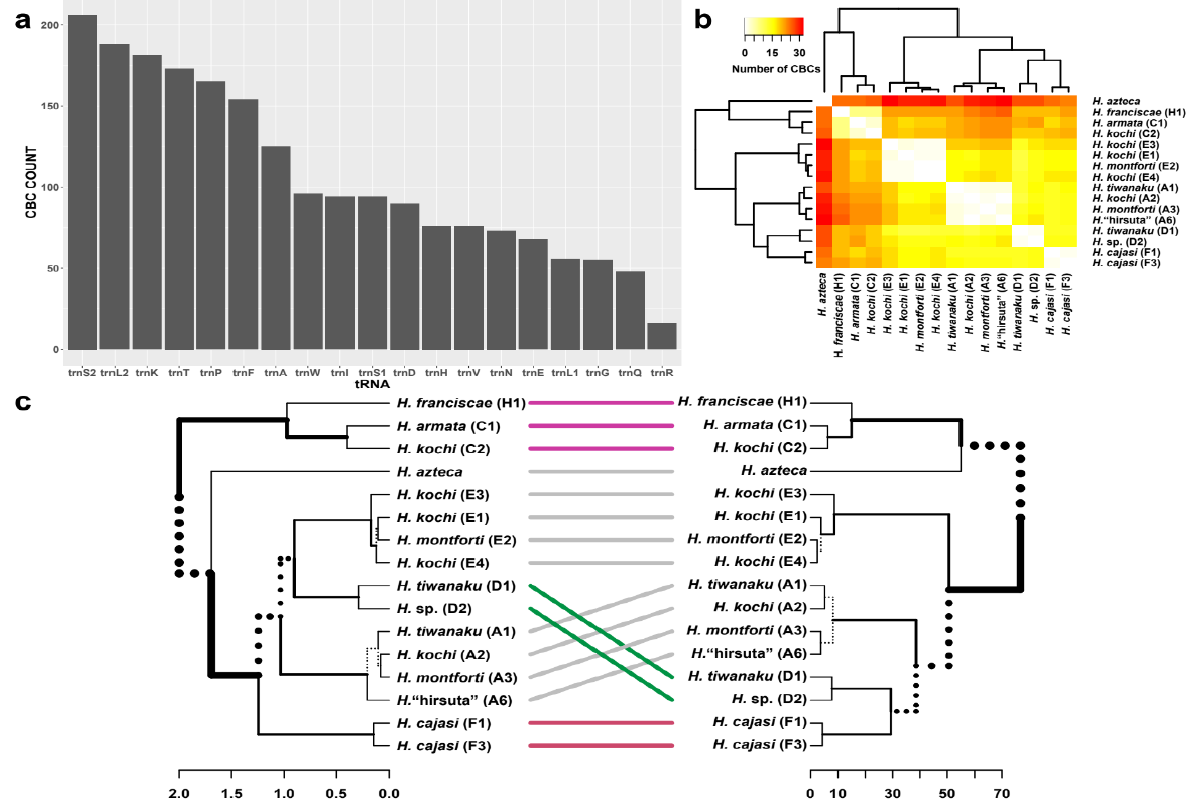
Figure 5. Analysis of the compensatory mutations. Bar plot showing the number of compensatory base changes (y-axis) in Hyalella tRNAs (x-axis) ( a ). Heatmap summarizing results of the hierarchical clustering analysis. Warmer colors (red–orange) indicate a higher number of compensatory base changes between samples ( b ). Tanglegram confronting the subtree of the genus Hyalella from Figure 1 (left) and the dendrogram of the hierarchical clustering analysis (right) ( c ). Dotted lines indicate branches differing in the two trees, while thick lines and in colors show similitudes between them.